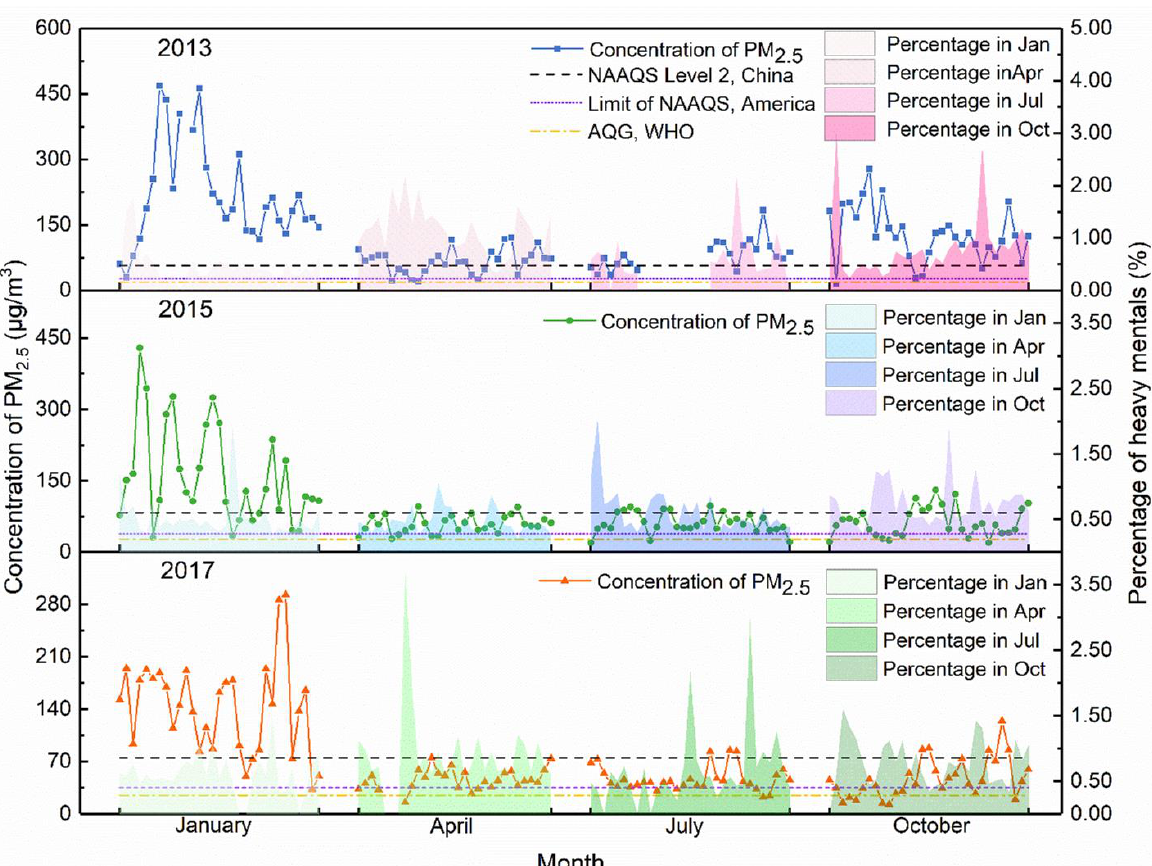
Figure 3. Mass concentration of PM2.5 and proportions of the 10 measured elements during the sampling period (n pm2.5 = 355, n heavy metals = 344).